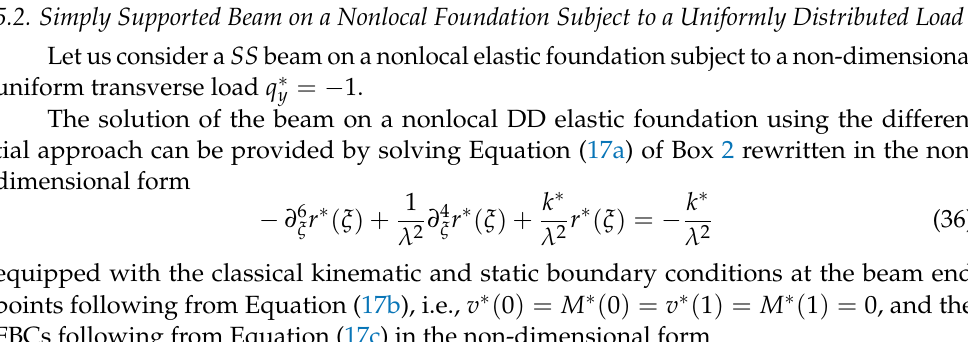
(cid:8) (cid:9) 0 + ,0.1,0.2,0.3,0.4,0.5 with k ∗ = { 0.4,2,10 }